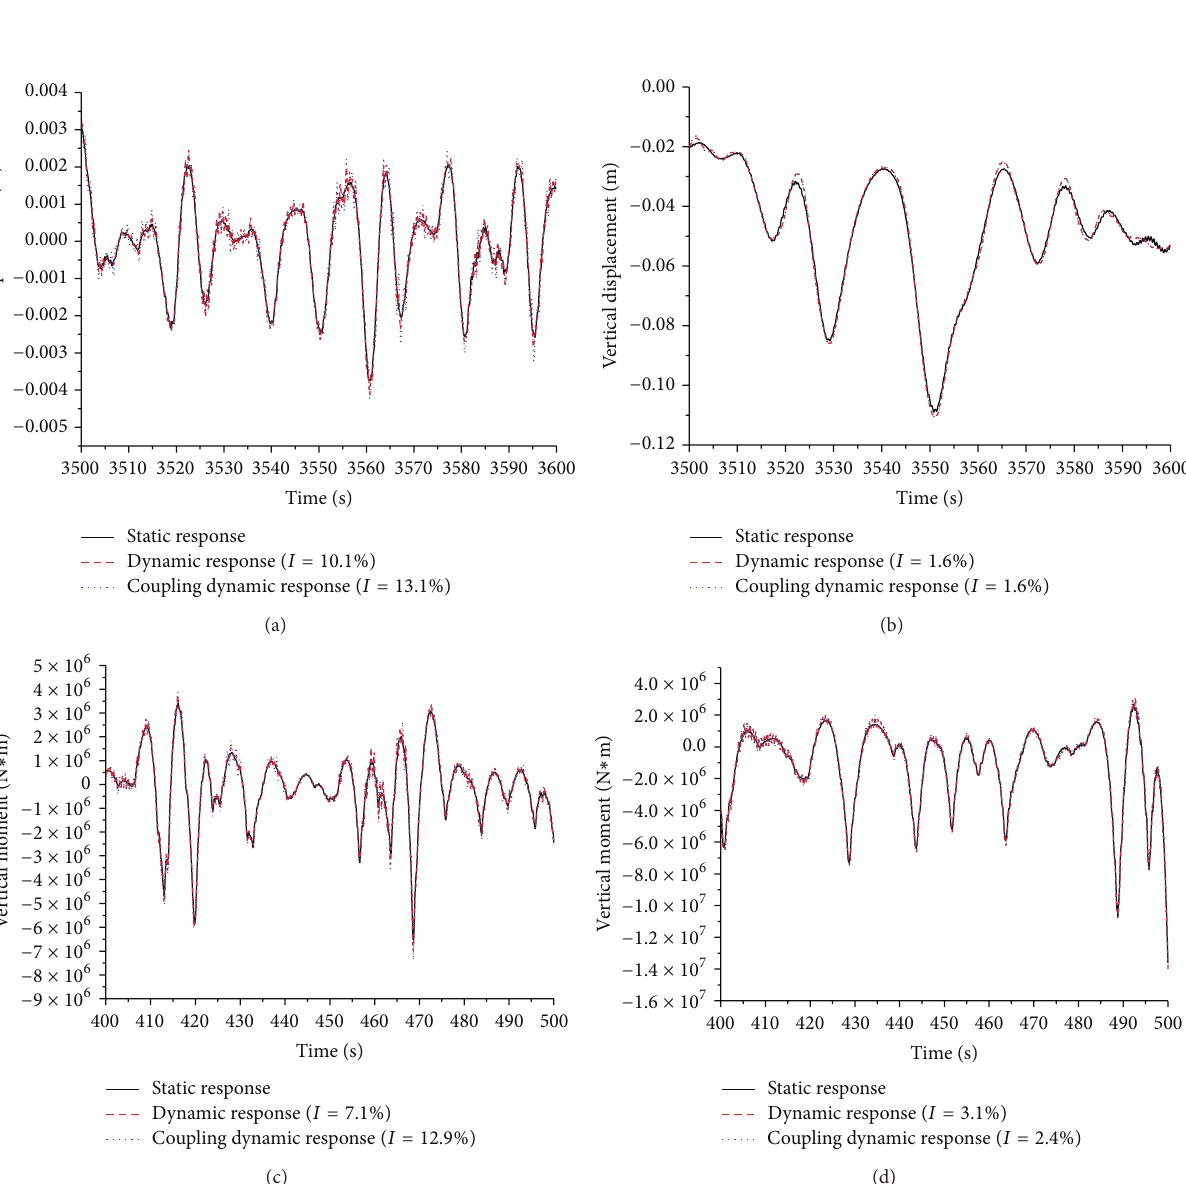
Figure 10: Time histories of responses of the bridge deck under the action of a traffic flow: (a) vertical displacement at point A; (b) vertical displacement at point C; (c) vertical moment at point A; (d) vertical moment at point